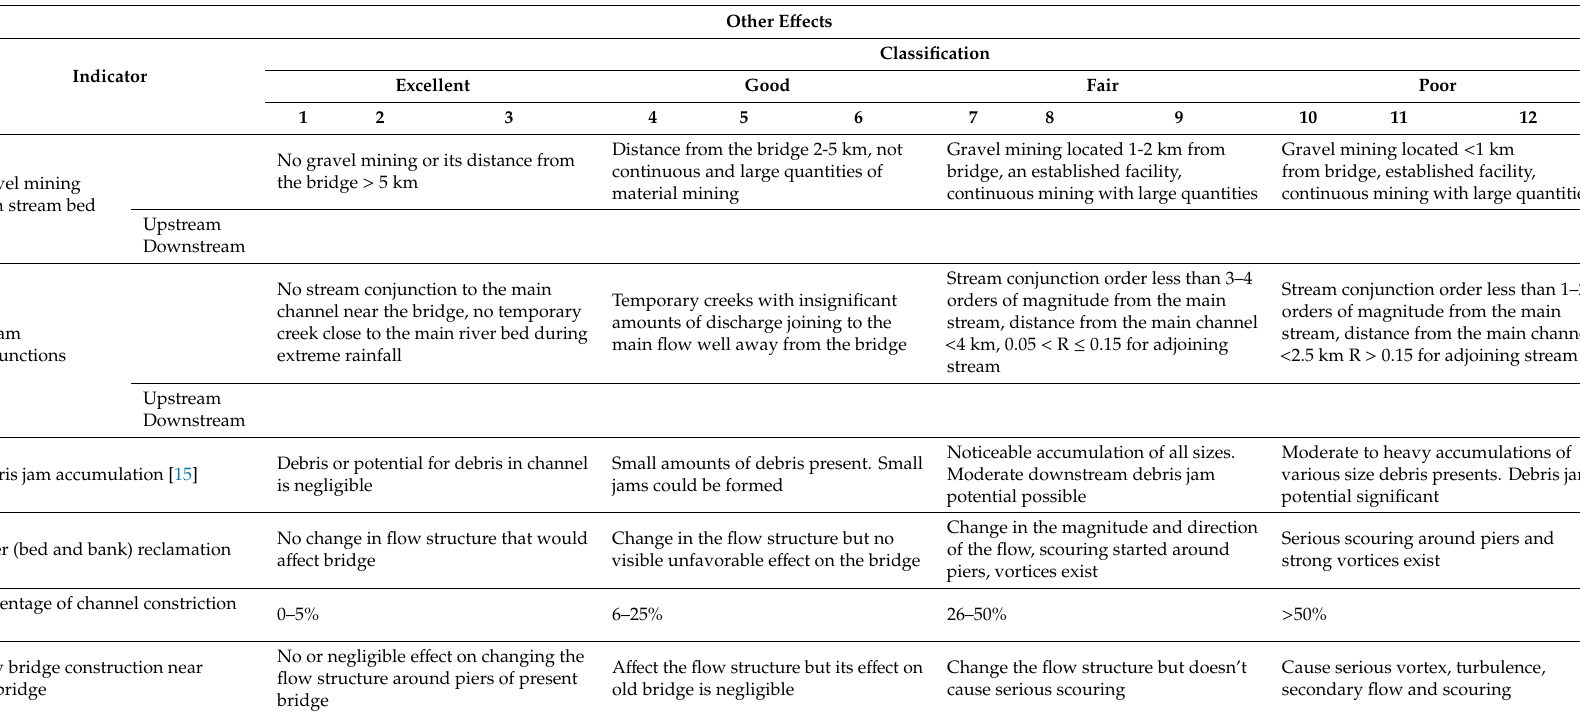
Table 6. Other e ff